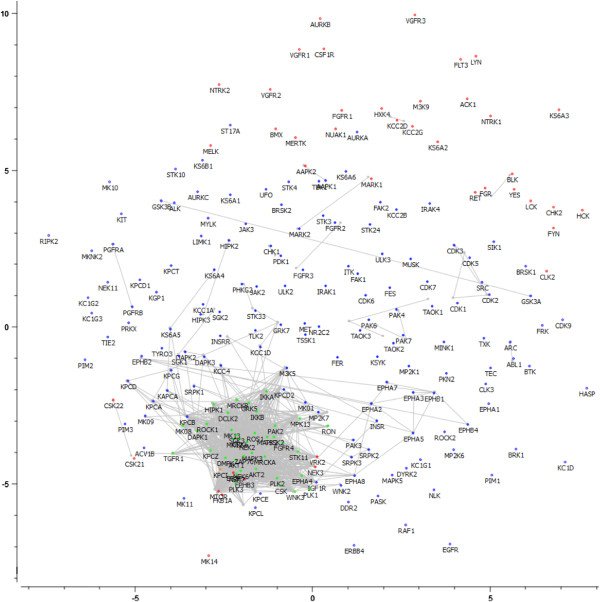
Multi-dimensional scaling (MDS) of kinases in bioactivity space. A low average signed relative stress level of 0.28 was obtained, meaning that the 2D representation of the kinases involves a low loss of information. Gray lines connect similar kinases. Kinases in outlier group 1 (shown in red) are clearly separated from the non-outliers, but vary amongst each other in terms of SAR similarity. In contrast, members of the second group of kinase outliers are densely scattered in a small area, indicating that these kinases are very similar to each other in terms of SAR similarity, but are apparently quite distinct from the non-outliers (shown in green). However, it is likely that the kinases in outlier group 2 tend to cluster together, due to the fact that most of these kinases share few active compounds with the other kinases in the dataset, making accurate comparison in terms of SAR similarities more difficult.